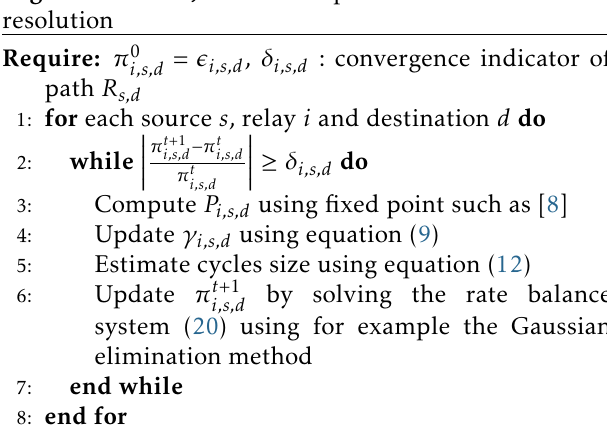
Algorithm 1 : Joint fixed point and rate balance resolution